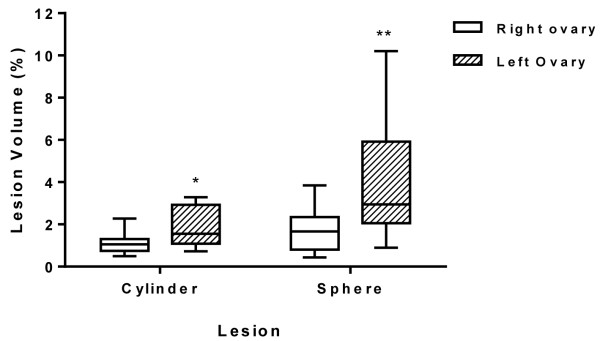
Box-and-whisker plot of mean ovarian tissue damage. Lesions estimated by cylinder or sphere volume. The upper line of the box represents the upper quartile, the thick line in the middle represents the median, and the lower line represents the lower quartile. Lesion volumes estimated by the two methods were statistically different between the two ovaries (*p = 0.021 and **p = 0.008).